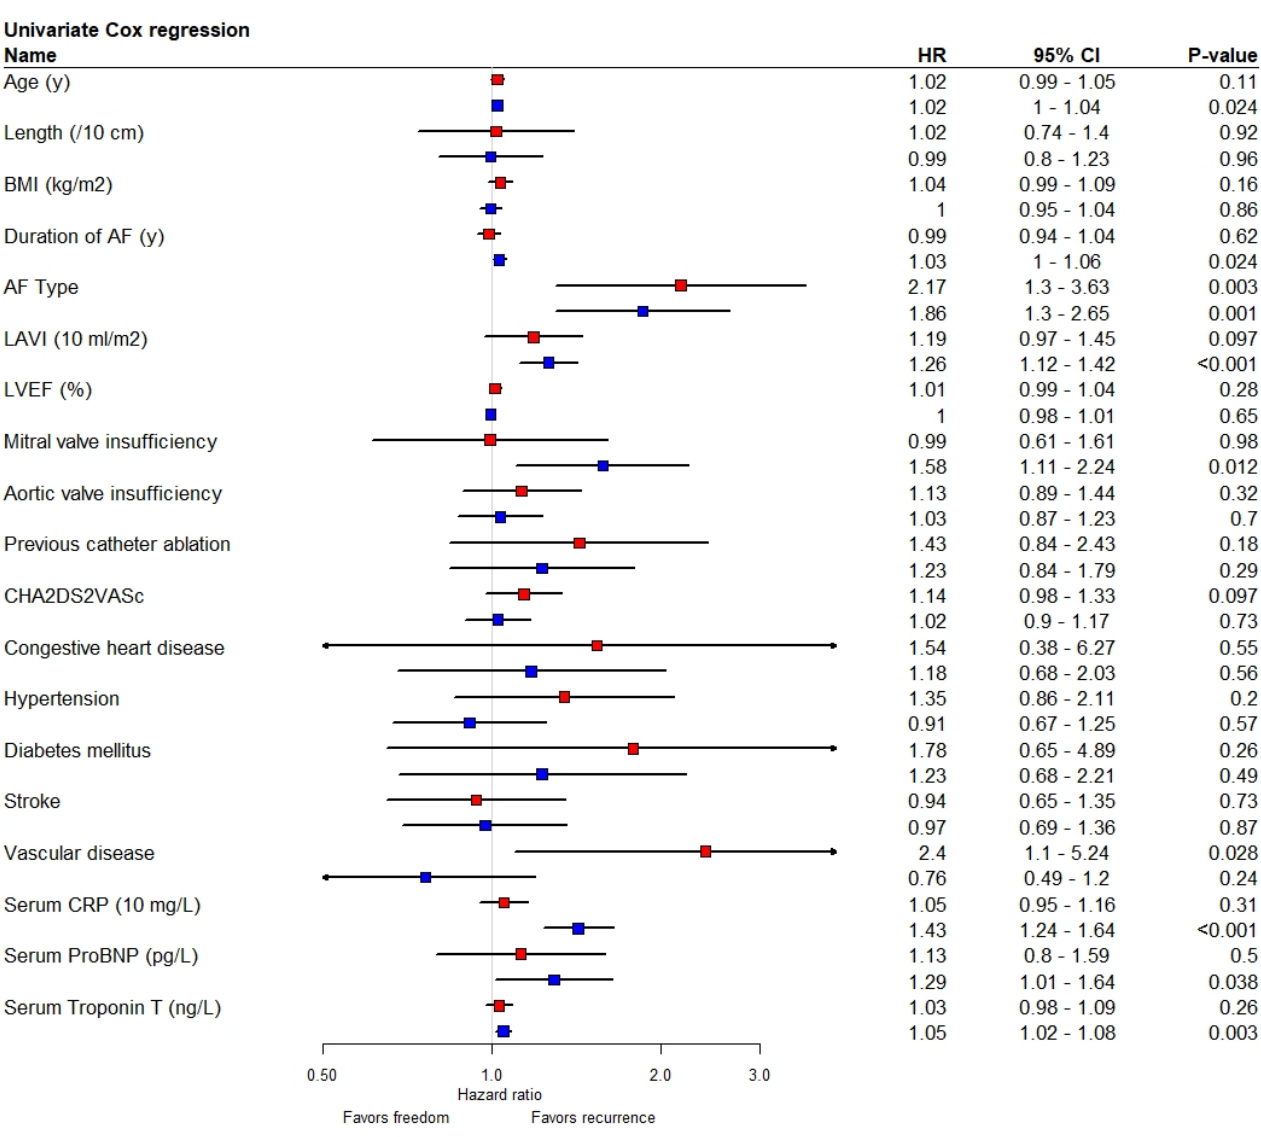
Figure 3. Univariate Cox regression of patient characteristics and freedom from AF recurrence for women (first, red) and men (second, blue) separately. AF atrial fibrillation, BMI body mass index, CI confidence interval, cm centimeter, CRP c-reactive protein, HR hazard ratio, kg kilogram, LAVI left atrial volume index, LVEF left ventricular ejection fraction, m meter, ml milliliter, MV mitral valve, ng nanogram, NT-proBNP n-terminal pro-brain natriuretic peptide, pg pictogram, y years µg microgram.